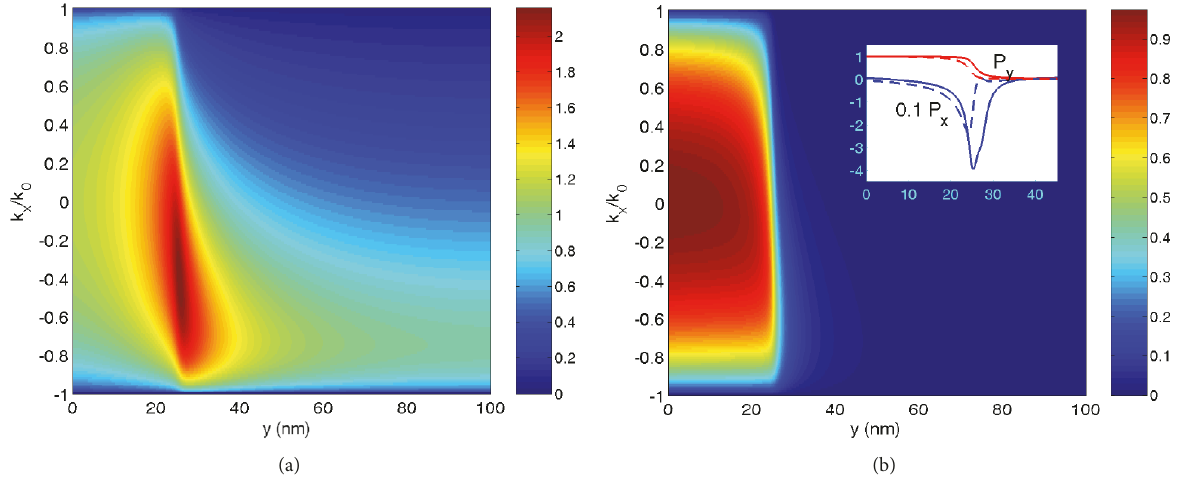
Figure 7: (Color online) (a) magnetic field pattern |𝐻 𝑧 |(𝑦,𝑘 𝑥 /𝑘 0 ) for the nonuniform metamaterial film of finite thickness 𝐿 𝑦 = 100 nm; (b) the 𝑦 component of Poynting vector, 𝑃 𝑦 (𝑦,𝑘 𝑥 /𝑘 0 ) . 𝑥 and 𝑦 components of Poynting vector; 𝑃 𝑥 (𝑦) and 𝑃 𝑦 (𝑦) are plotted in the inset for 𝑘 /𝑘 = −0.4 (solid lines) and 𝑘 /𝑘 = 0.4 (dashed lines). Near the resonance point ( 𝑦 ≈ 25 nm) 𝑃 𝑥 0 𝑥 0 energy flows mainly in the opposite 𝑥 direction. The radiation wavelength is 500